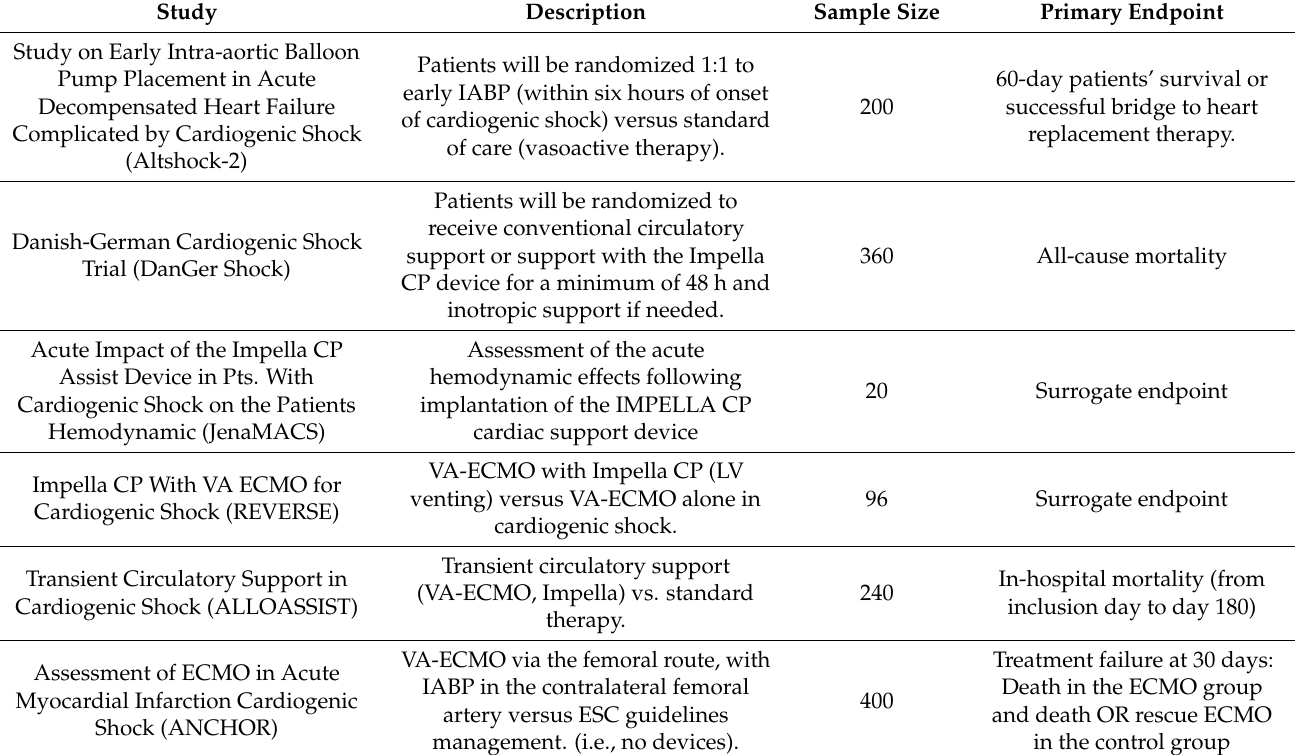
Table 3. On-going MCS trials in CS